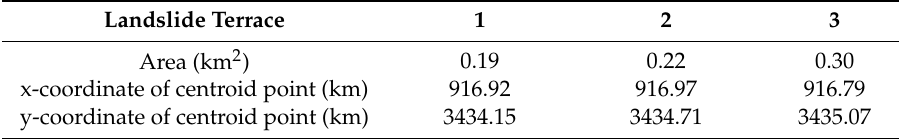
Figure 10. Geomorphological features of the Xinpu landslide showing ( a ) front view and ( b ) lateral view (the measuring points are marked with red stars). Table 3. The measurement result of landslide terrace 1–3 in the Xinpu landslide.